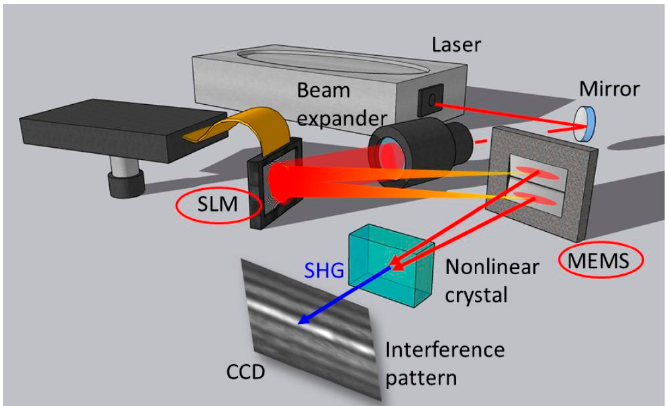
Figure 2. Combined system containing a high-resolution LCoS-SLM and a shape-variable MEMS corresponding to configuration Com 1 (schematically). As an example, the drawn MEMS represents a Fresnel bi-mirror. Beam shaping is evaluated with a CCD camera. The nonlinear crystal symbolizes the options for additional nonlinear processing—here, the extraction of SHG autocorrelation signal. In general, the MEMS can be a single or multiple reflective or transmissive structure.